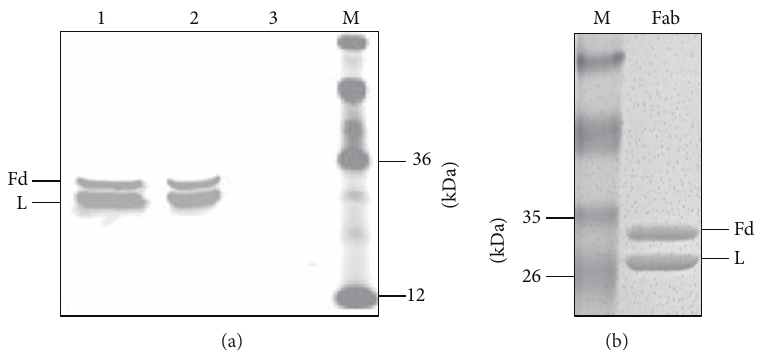
Figure 3: Expression and purification of the LF8-Fab. (a) A goat antihuman Fab and IRDye 800CW donkey antigoat IgG were used to detect Fab expression in Western blotting. Both heavy chain Fd (Fd) and light chain (L) were expressed. Lane 1, supernatant of sonicated lysate; lane 2, pellet of sonicated lysate; lane 3, lysate of untranfected E. coli HB2151 as negative control; lane 4, protein marker. (b) Coomassie blue staining showed that heavy chain Fd (Fd) and light chain (L) of the LF8-Fab were equally expressed after the purification of IMAC and IEC.